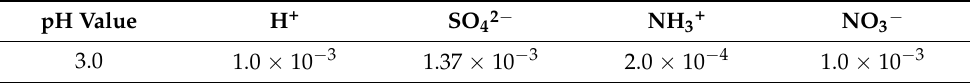
Figure 2. Spray-light corrosion cycle system diagram. Table 4. Chemical composition of the simulated acid rain solution